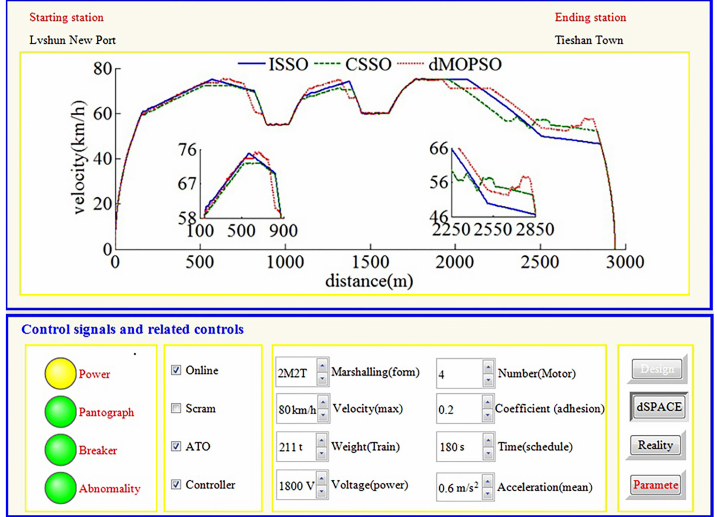
Figure 13. The HILS tracking control curves of different algorithms for rail transit line No.12 in Dalian